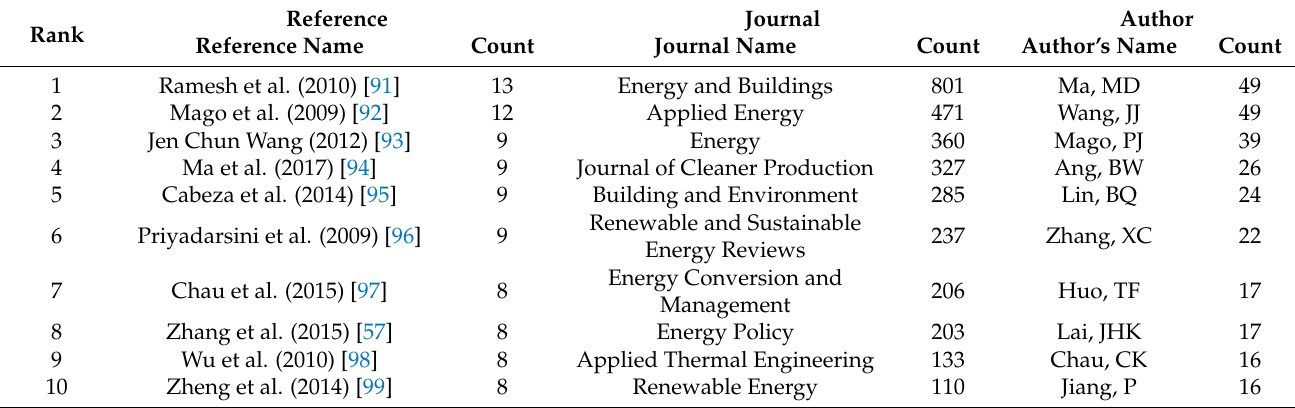
Table 5. Top ten most co-cited references, journals, and